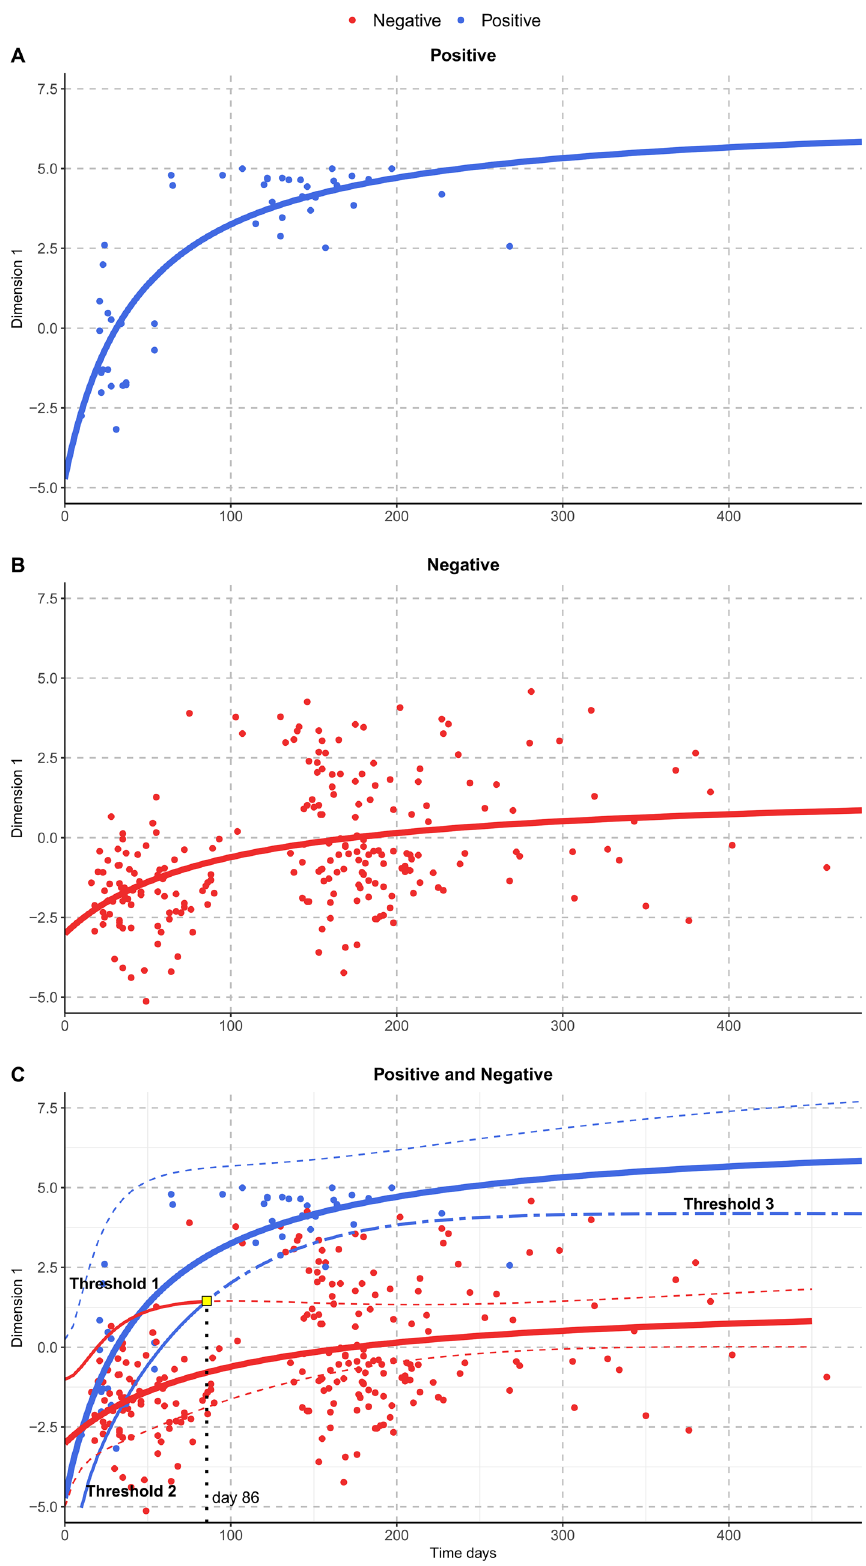
Figure 3. Time course of PCA Dimension 1 for individuals with Positive GOS (panel A ) and for individuals with Negative GOS (panel B ) in the Training sample. Dots represent the individual scores (blue dots for Positive GOS group and red dots for Negative GOS group) whereas thick continuous lines are the predictions from the Michaelis Menten model. Panel ( C ) shows the observed scores and the model fitting along with the corresponding 95% confidence intervals (dashed lines) based on a Monte Carlo approach along with the three thresholds: Threshold 1 (fine red continuous line), Threshold 2 (fine blue continuous line), Threshold 3 (blue two-dashed continuous